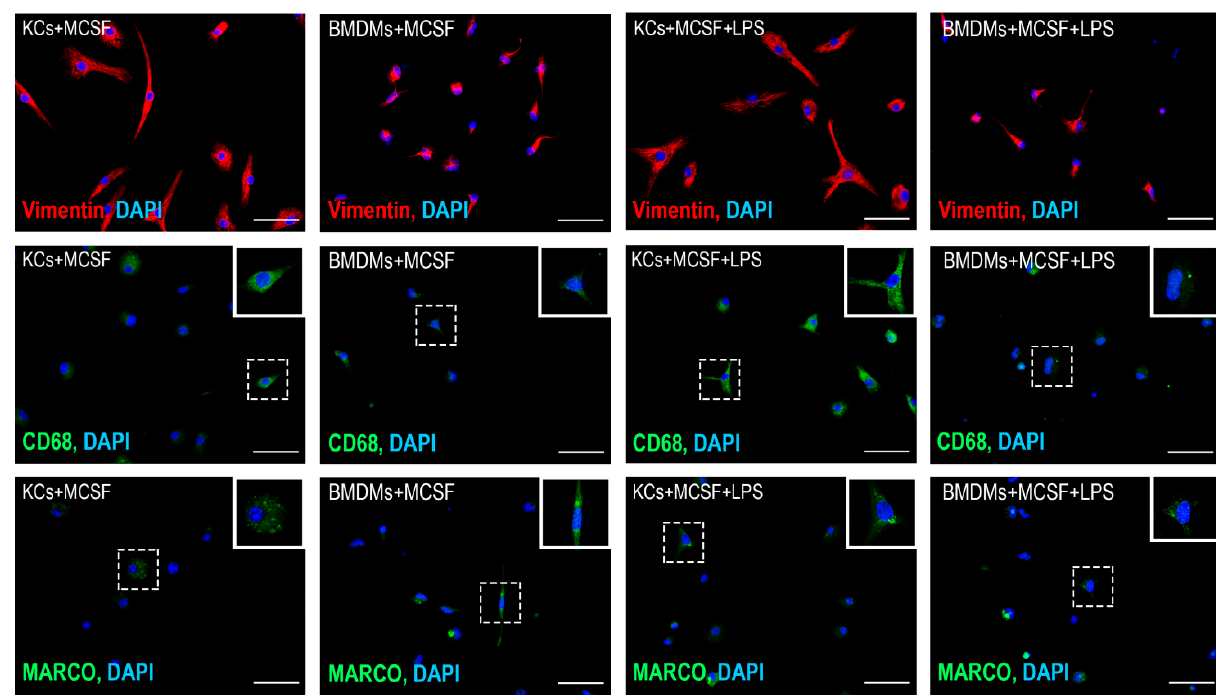
Figure 3. Immunofluorescence detection of Vimentin, CD68, and MARCO proteins in cultured bone marrow-derived macrophages (BMDMs) and Kupffer cells (KCs). Fluorescent microscopy images displaying anti-Vimentin and anti-CD68 (PE, red), anti-MARCO (FITC, green) immunostaining, and the counterstained cell nuclei (DAPI, blue), magnification × 400; bars, 50 μ m. The highlighted dotted line cells are shown in the enlarged boxes.